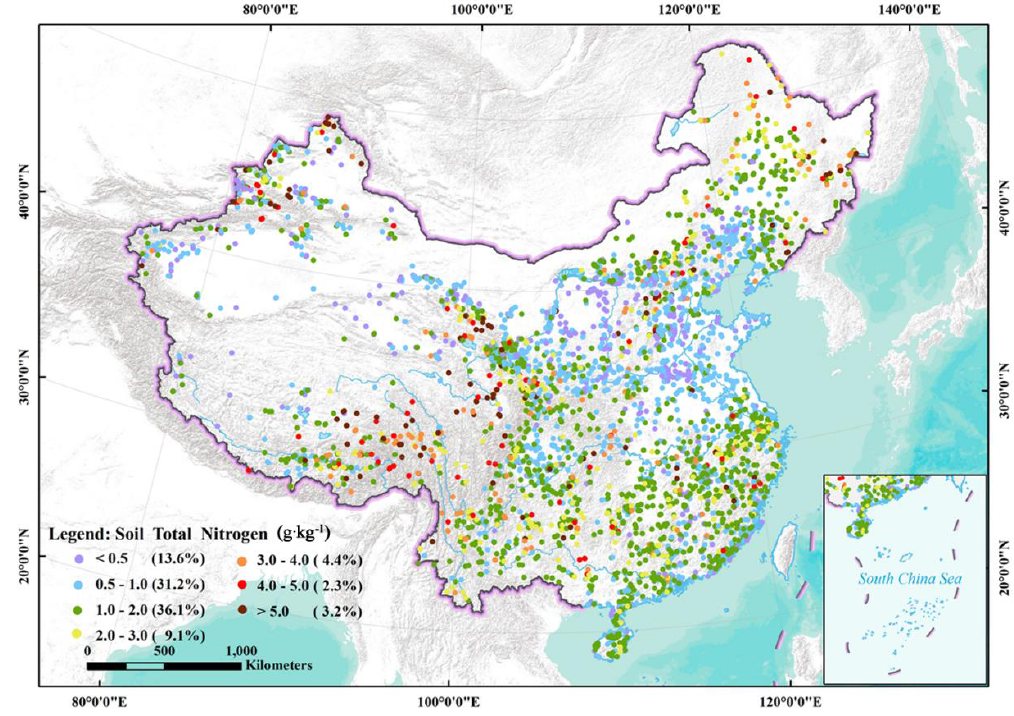
Figure 1. The location and topsoil (0–20 cm) total nitrogen (TN) content of 4022 soil data records.